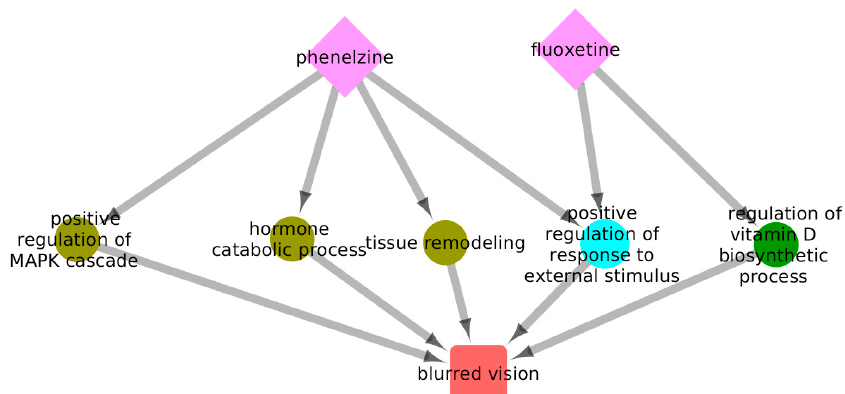
Figure 10. A subgraph of fluoxetine and phenelzine with five pathways. This is an illustration of the manifestation of blurred vision as an ADR to the administration of phenelzine and fluoxetine. Phenelzine and fluoxetine may both perturb the positive regulation of the response to an external stimulus GO term in a mode 1 configuration. Additionally, mode 2 contributions may be observed, with fluoxetine being independently able to perturb the regulation of the vitamin D biosynthetic process and phenelzine being able to perturb the positive regulation of MAPK cascade, hormone catabolic processes, and tissue remodeling. The perturbation of any such GO terms may lead to the manifestation of blurred vision.